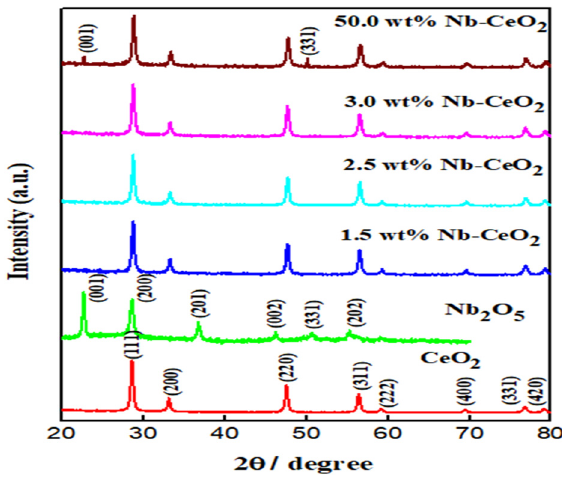
Figure 1: XRD patterns of the prepared